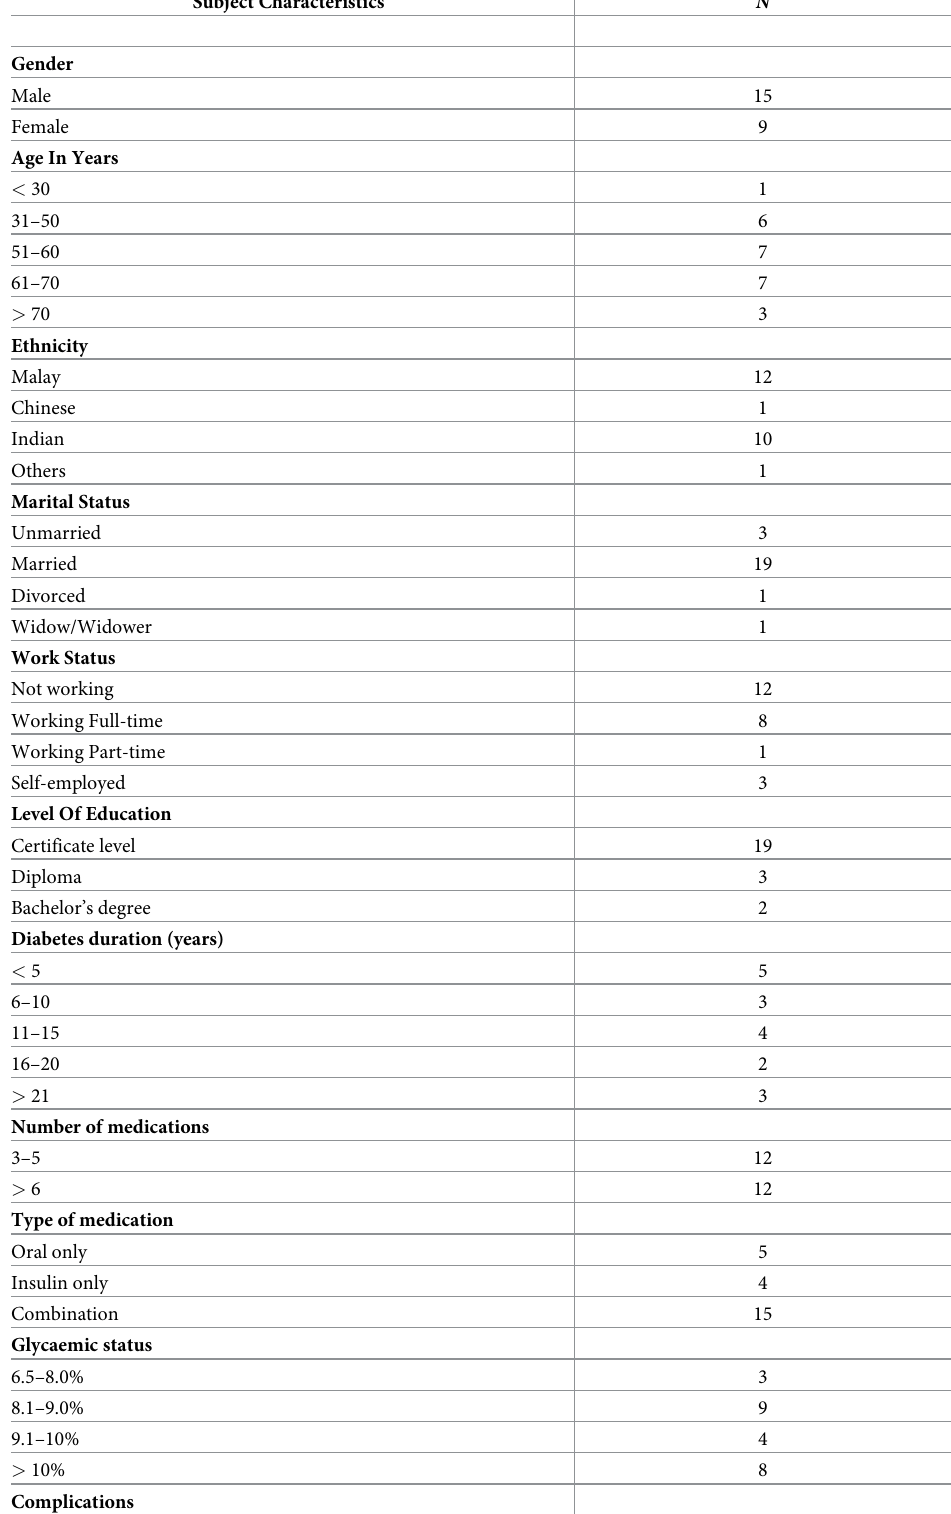
Table 1. Demographic details of T2D participants of the